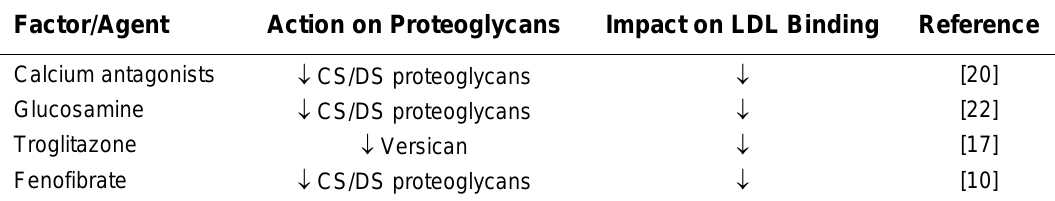
Factors that Decrease Proteoglycan Synthesis in